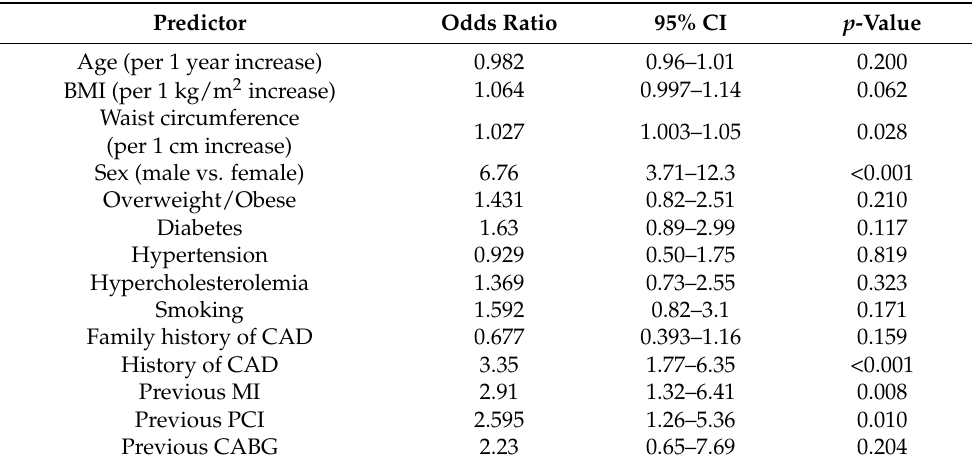
Table 3. Independent predictors of the presence of ischemia in myocardial scintigraphy. Predictor Odds Ratio 95% CI p -Value Sex (male vs. female) 8.86 4.66–16.83 <0.001 BMI (per 1 kg/m 2 increase) 1.13 1.05–1.22